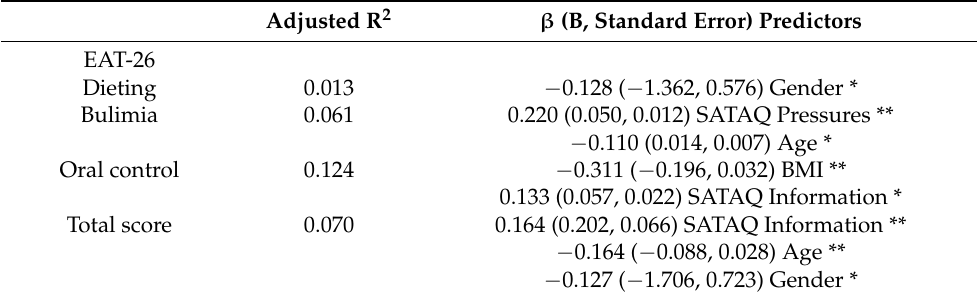
Table 3. Stepwise multiple linear regression predicting EAT-26 by demographic characteristics, OEQ and SATAQ scales.